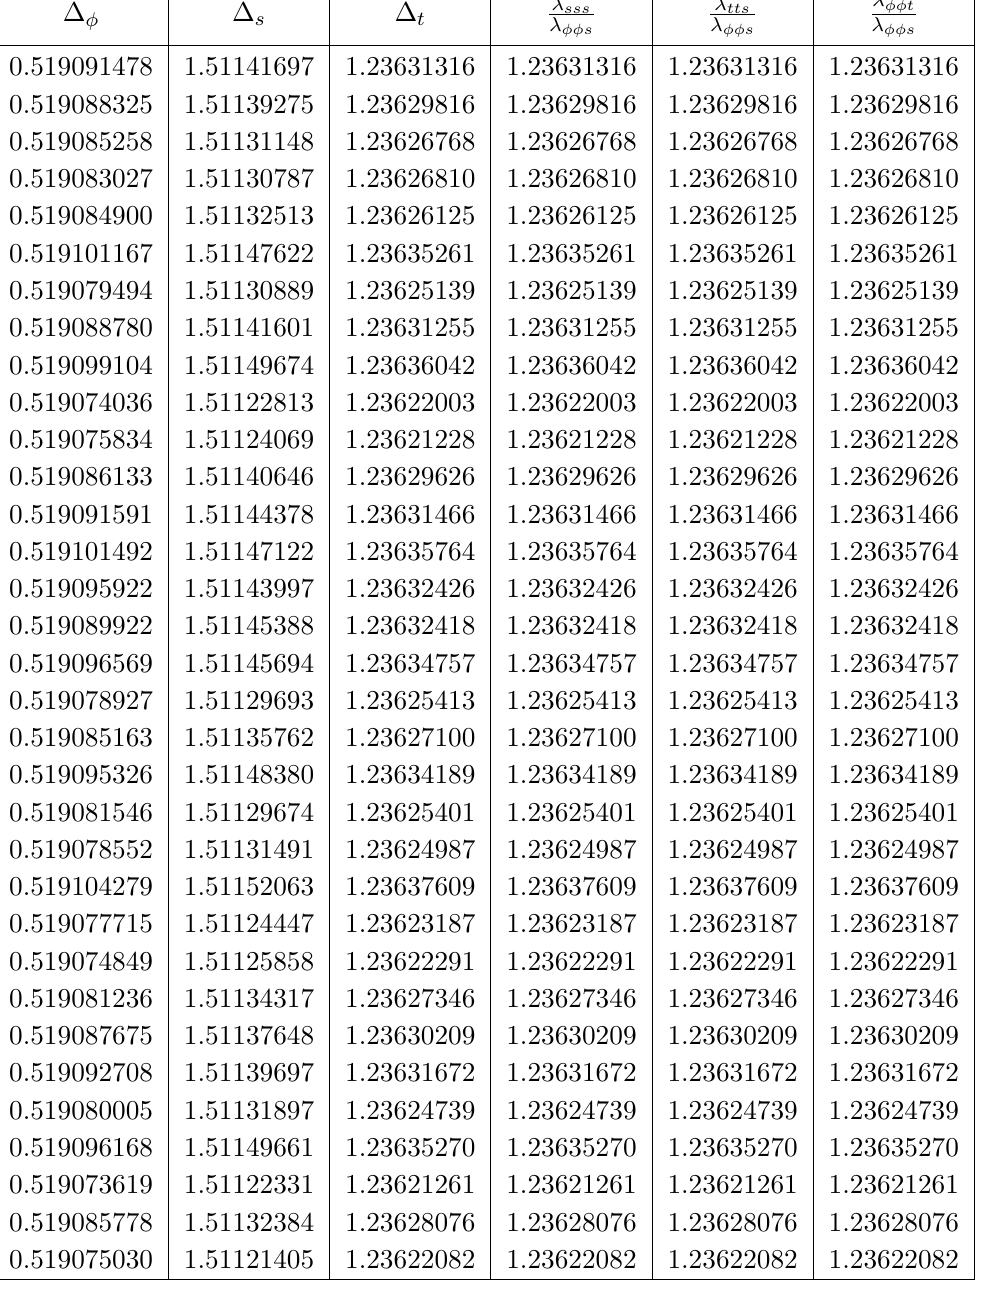
Table 7 . Allowed points in the (cid:3) = 43